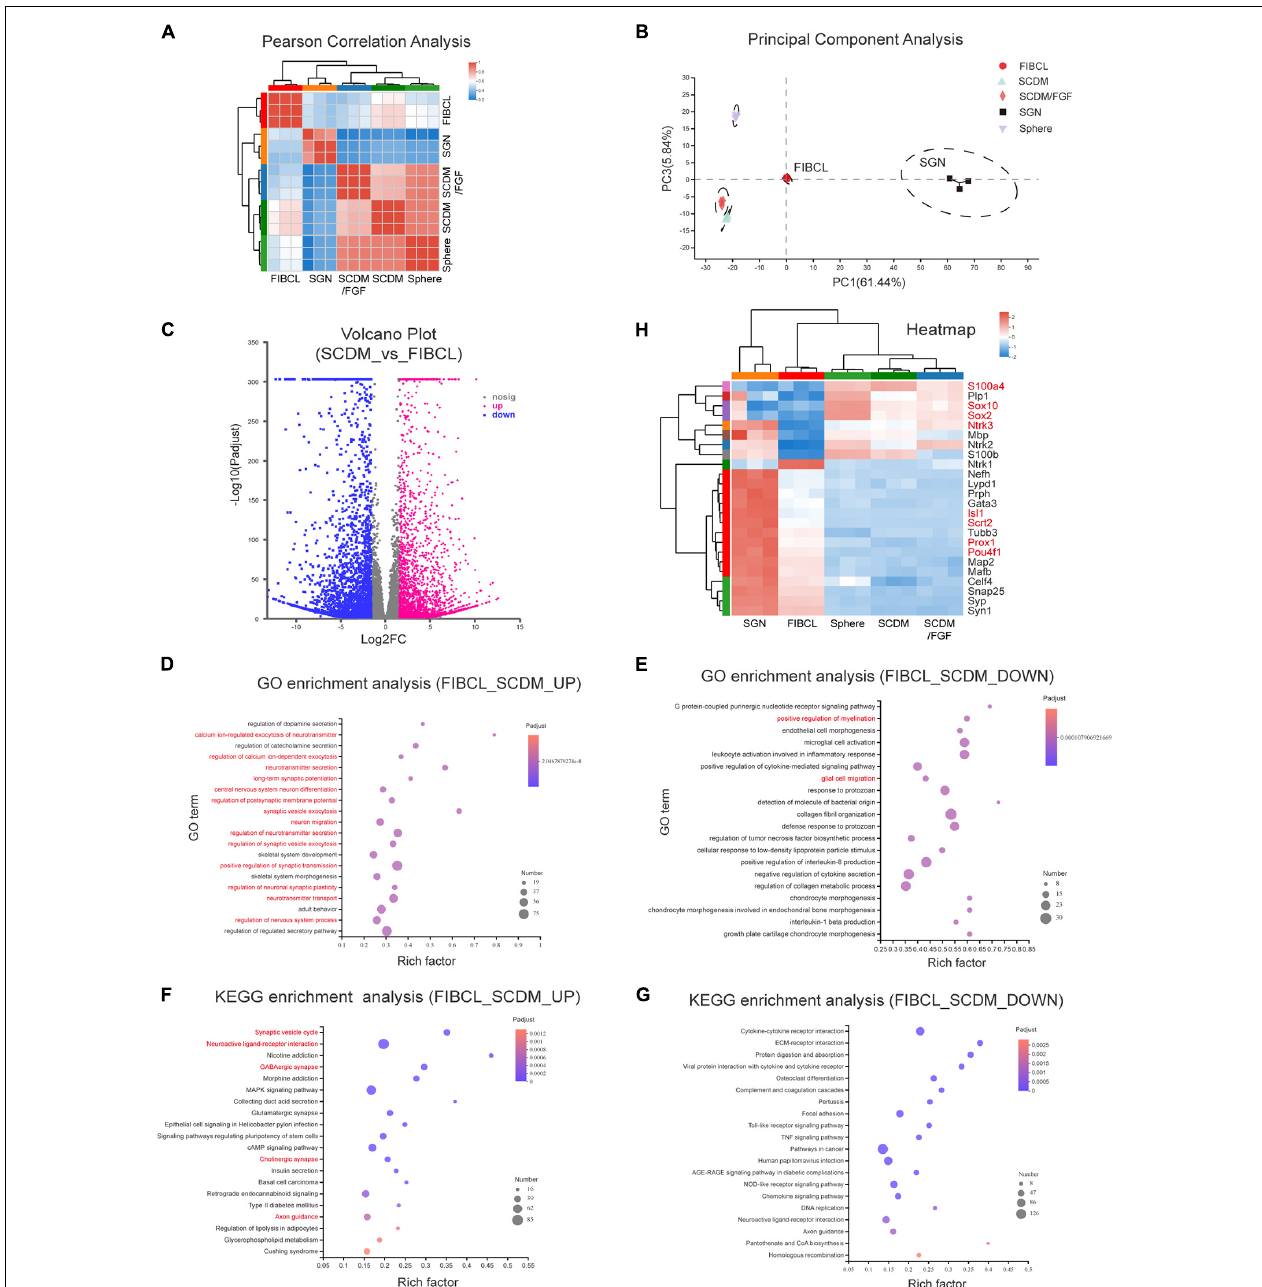
FIGURE 8 | Transcriptomic analyses of the induced neurons. (A,B) Pearson correlation analysis (A) and principal component analysis (B) of neurospheres, differentiated culture in SCDM, SCDM/FGF, FIBCL media, and primary SGNs. (C) Volcano graph of the genes upregulated and downregulated in the FIBCL-induced neurons compared to the SCDM media. (D,E) GO enrichment analysis of upregulated (D) and downregulated (E) functional pathways in the FIBCL-induced neurons compared to the SCDM media. (F,G) KEGG enrichment analysis of upregulated (D) and downregulated (E) cellular processes in the FIBCL-induced neurons compared to the SCDM media. (H) Heatmap graph of specific glial and neuronal genes expressed in spheres, differentiated culture in SCDM, SCDM/FGF, FIBCL media, and primary SGNs. Changes in expression of selected genes (gene symbol highlighted in red) were validated by RT-qPCR in Supplementary Figure 4